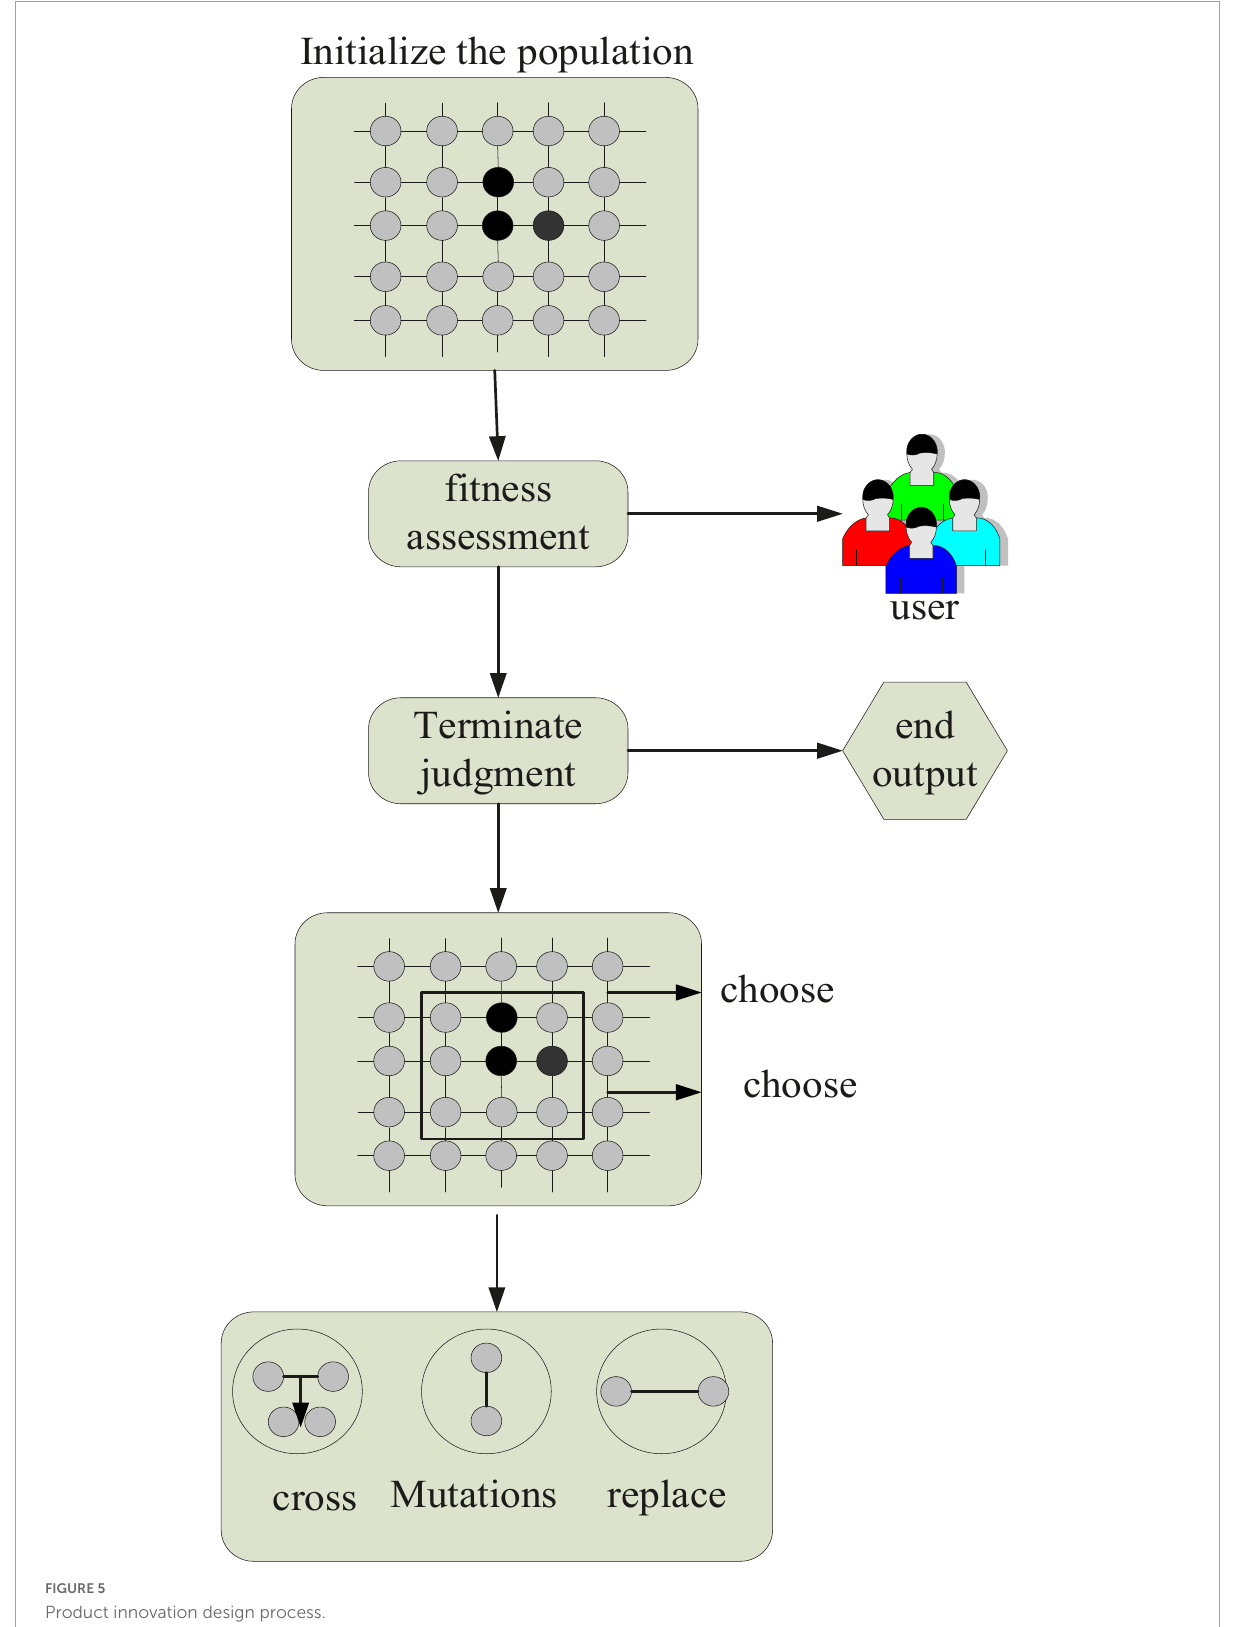
FIGURE5 Product innovation design